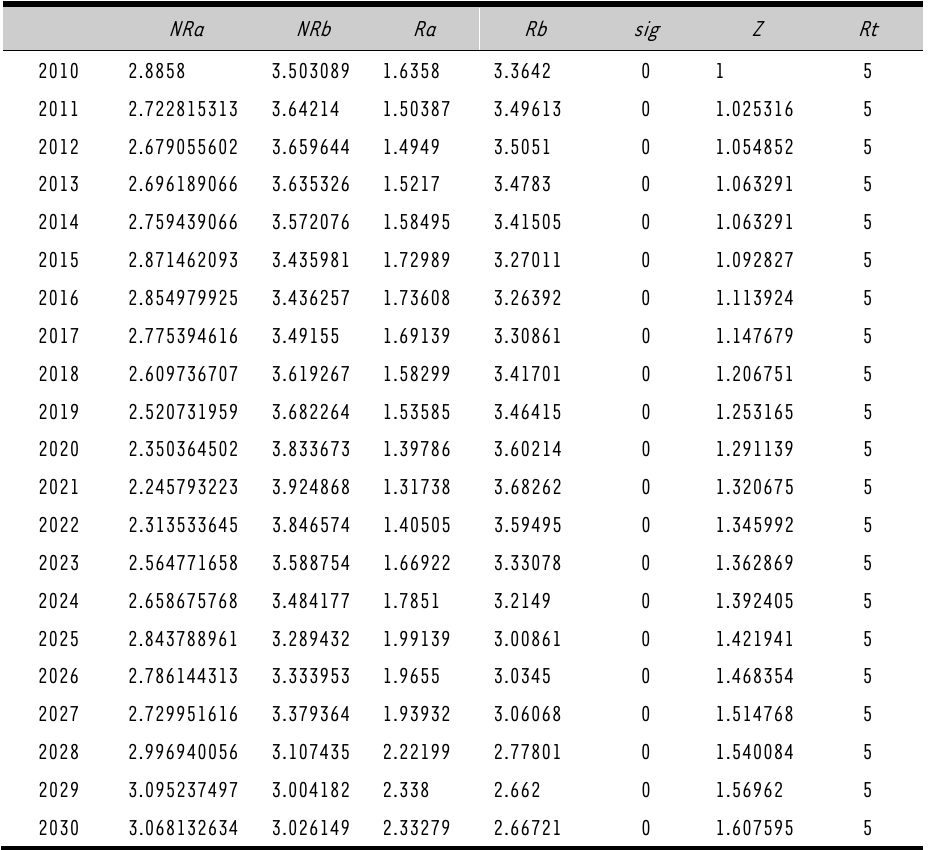
TABLE 9: Data used for South Africa to simulate the reaction function between the ‘environmentalist’ and the ‘energy producer’, as proposed by the IRP 2010-2030, base case scenario, using 2010 as the base